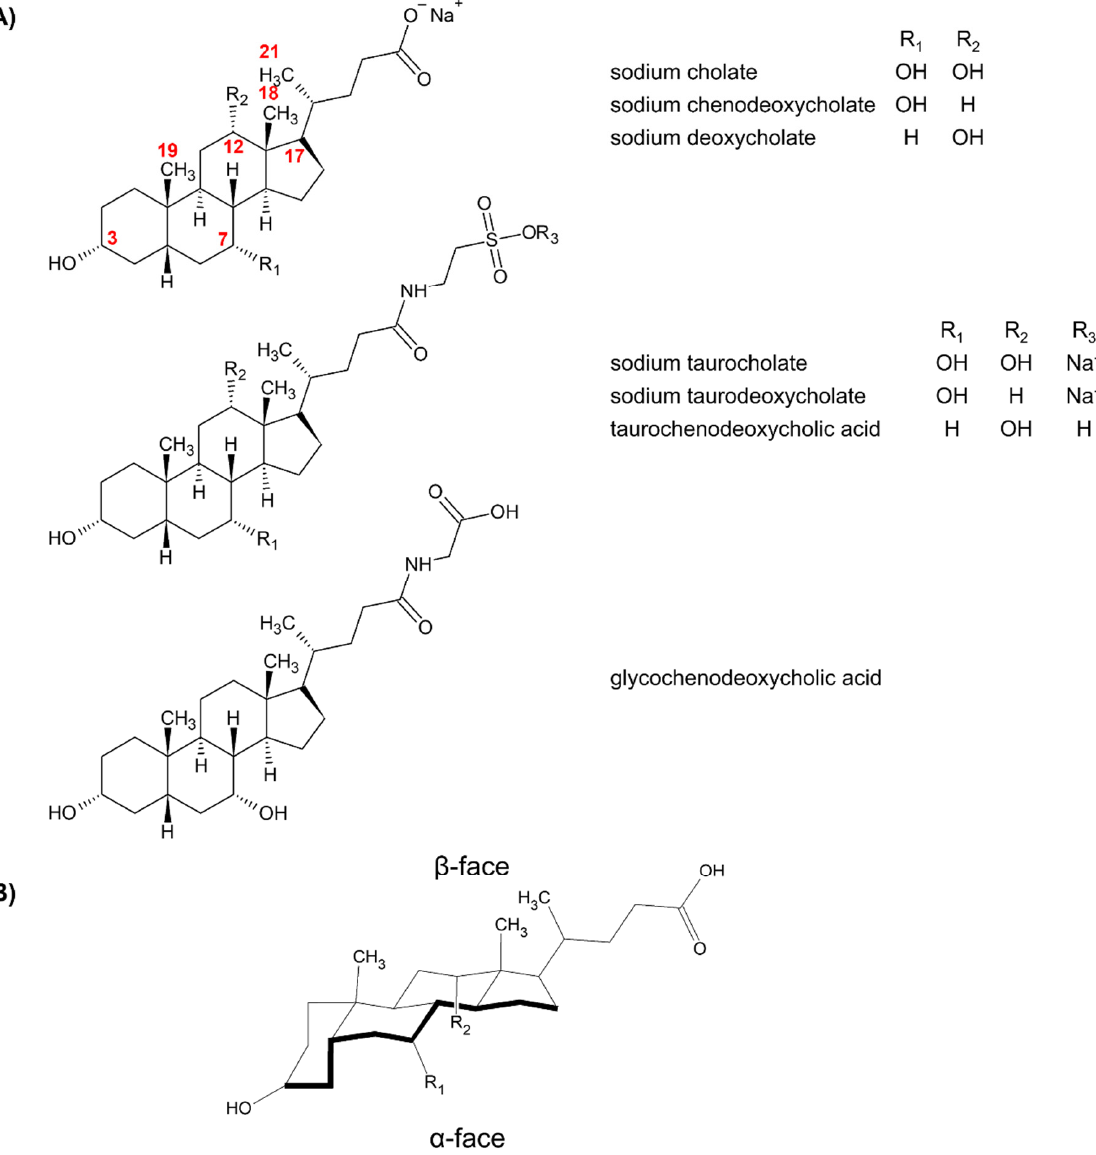
Figure 1. ( A ) Structures of bile acids commonly utilized in MEKC from 2000 to 2020. The locants of important positions in sodium cholate or sodium deoxycholate have been indicated. ( B ) Location of the α - and β -faces of bile salts using cholic acid as example. Figure 1B was reprinted with permission from [17], © 2021 American Chemical Society.